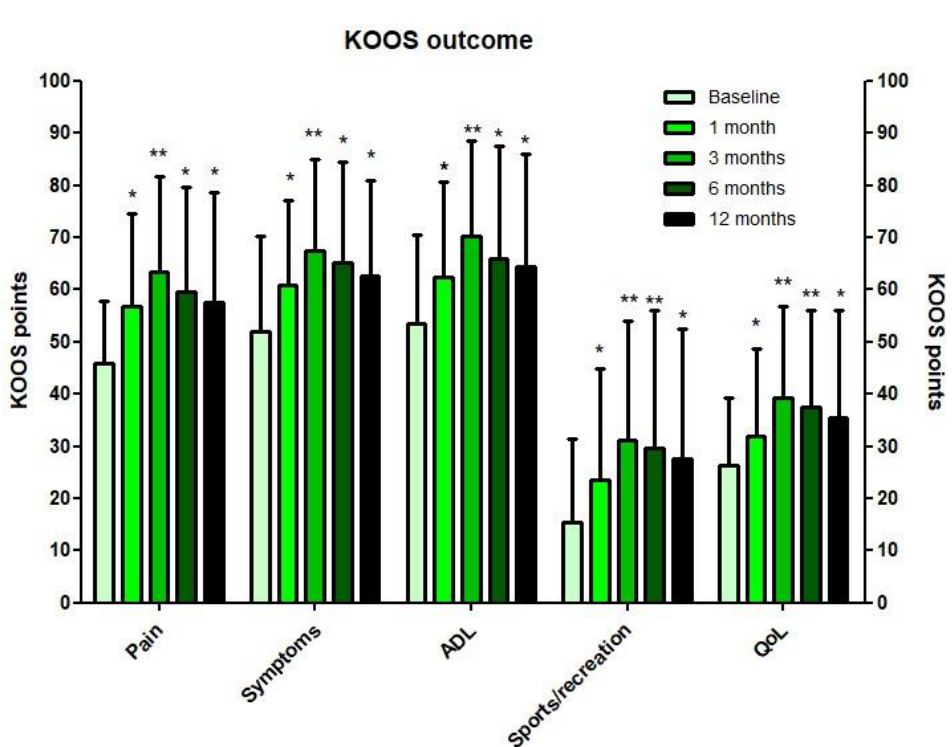
Figure 3. KOOS outcomes of the index knees ( n = 64) after a single injection with autologous MFAT. (ADL, activities of daily living; QoL, quality of living). * significant difference compared to baseline. ** significant difference compared to baseline and 1 month.